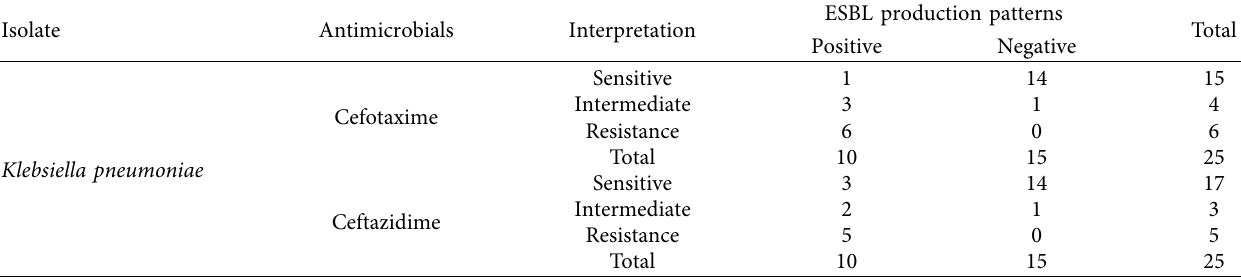
Table 4: ESBL patterns of Klebsiella pneumoniae isolated from UTI-suspected patients who attended Bahir Dar City health institutions, Bahir Dar, Northwest Ethiopia, 2019.